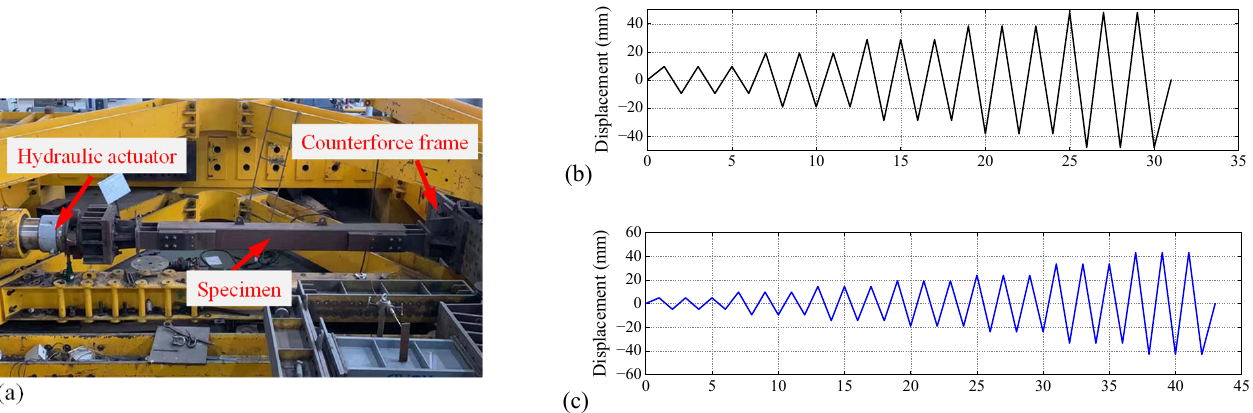
Figure 9. Reversed cyclic test and loading protocols: ( a ) on‑site loading equipment; ( b ) loading protocols for FBRB specimen; and ( c ) loading protocols for FE specimen.